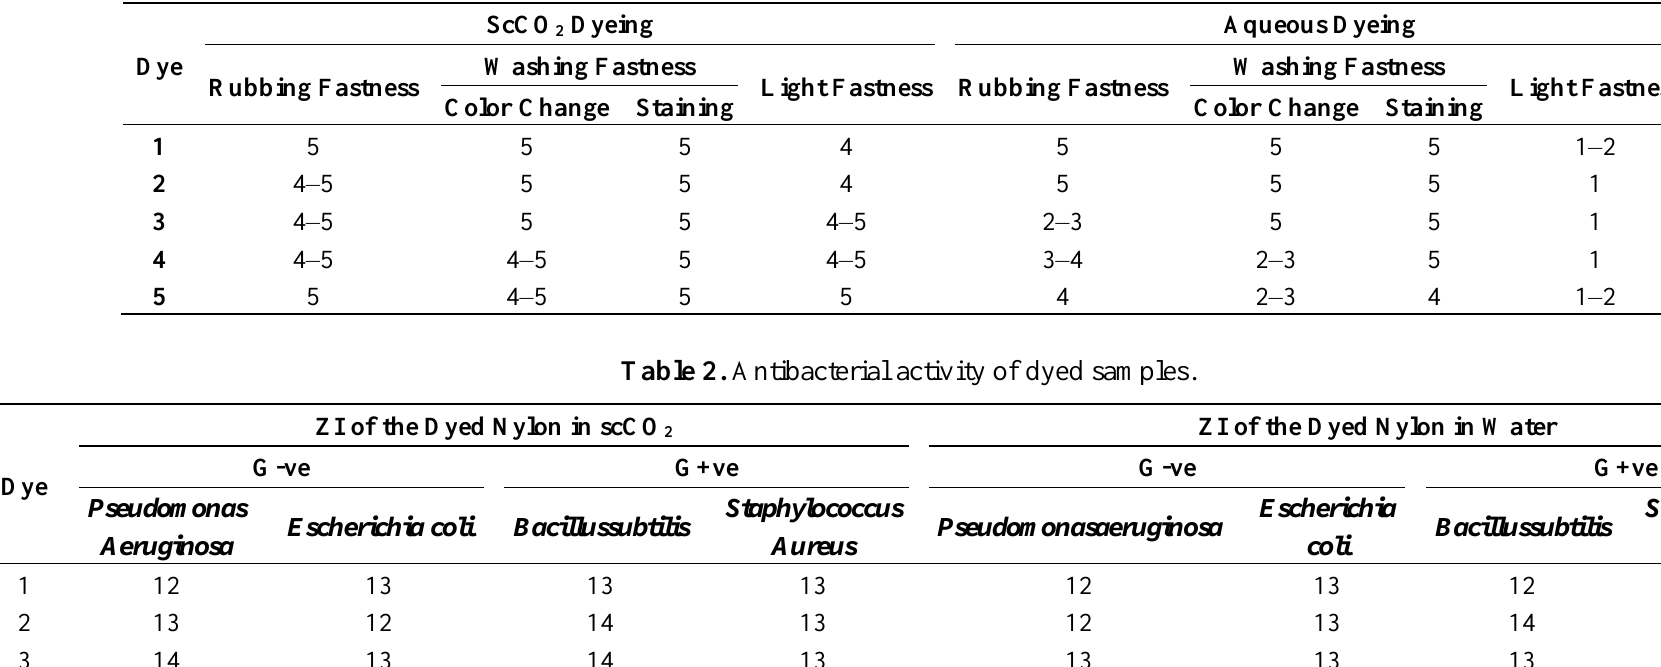
Table 1. Fastness properties of dyed nylon 6 samples.